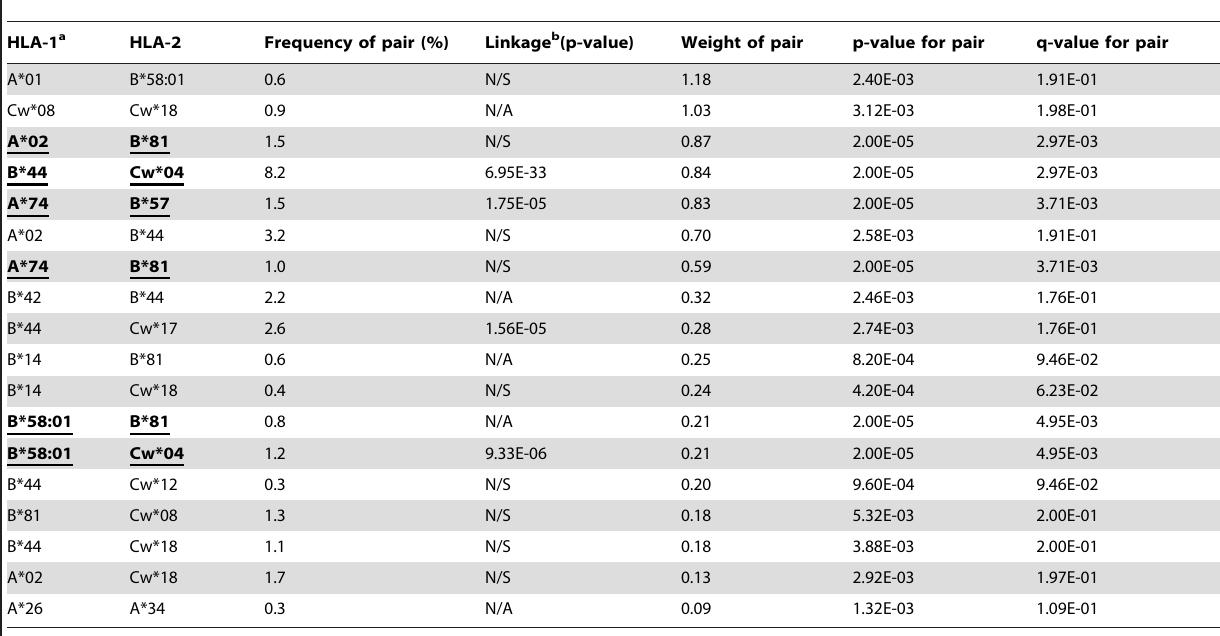
Table 4. Multivariate analysis of pairs of HLA Class I alleles, showing pairs associated with favourable impact on HIV-1 disease control, with respect to maintenance of CD4 + T cell count and/or viral load suppression (q , 0.2).